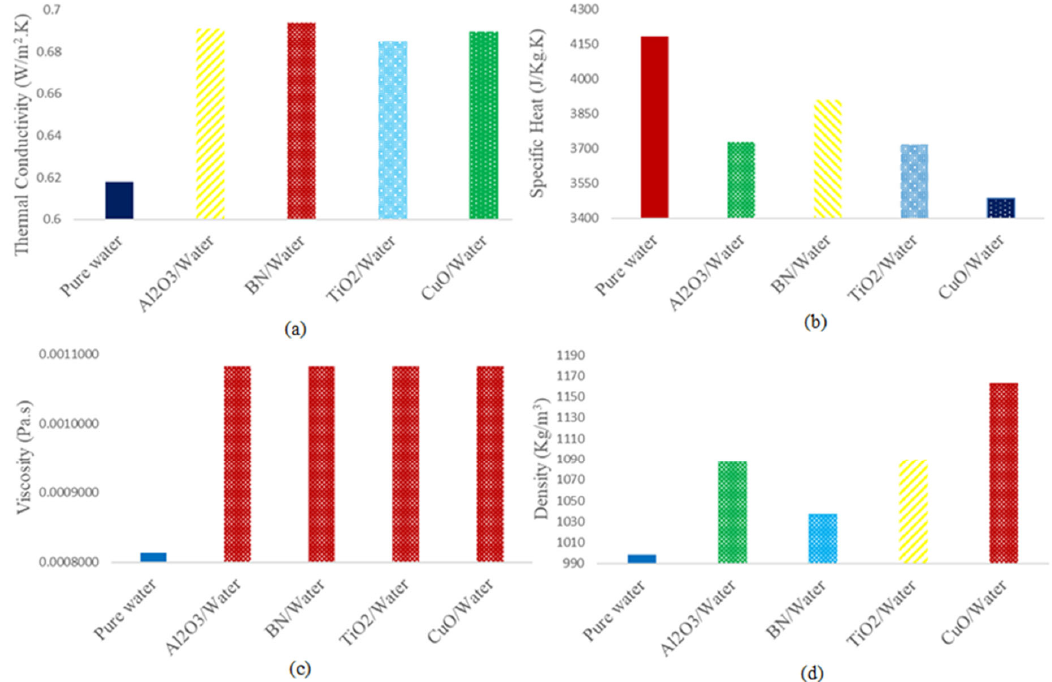
Figure 3. Properties of nanofluids and pure water at volume fraction ratio of 3% and 303.15 K for ( a ) Thermal conductivity, ( b ) Specific heat, ( c ) Viscosity and ( d ) Density. As can be seen from this figure, the properties of the coolant change in different mixtures. In the transition from base fluid water to nanofluid, thermal conductivity, viscosity and density values increase while specific heat decreases.